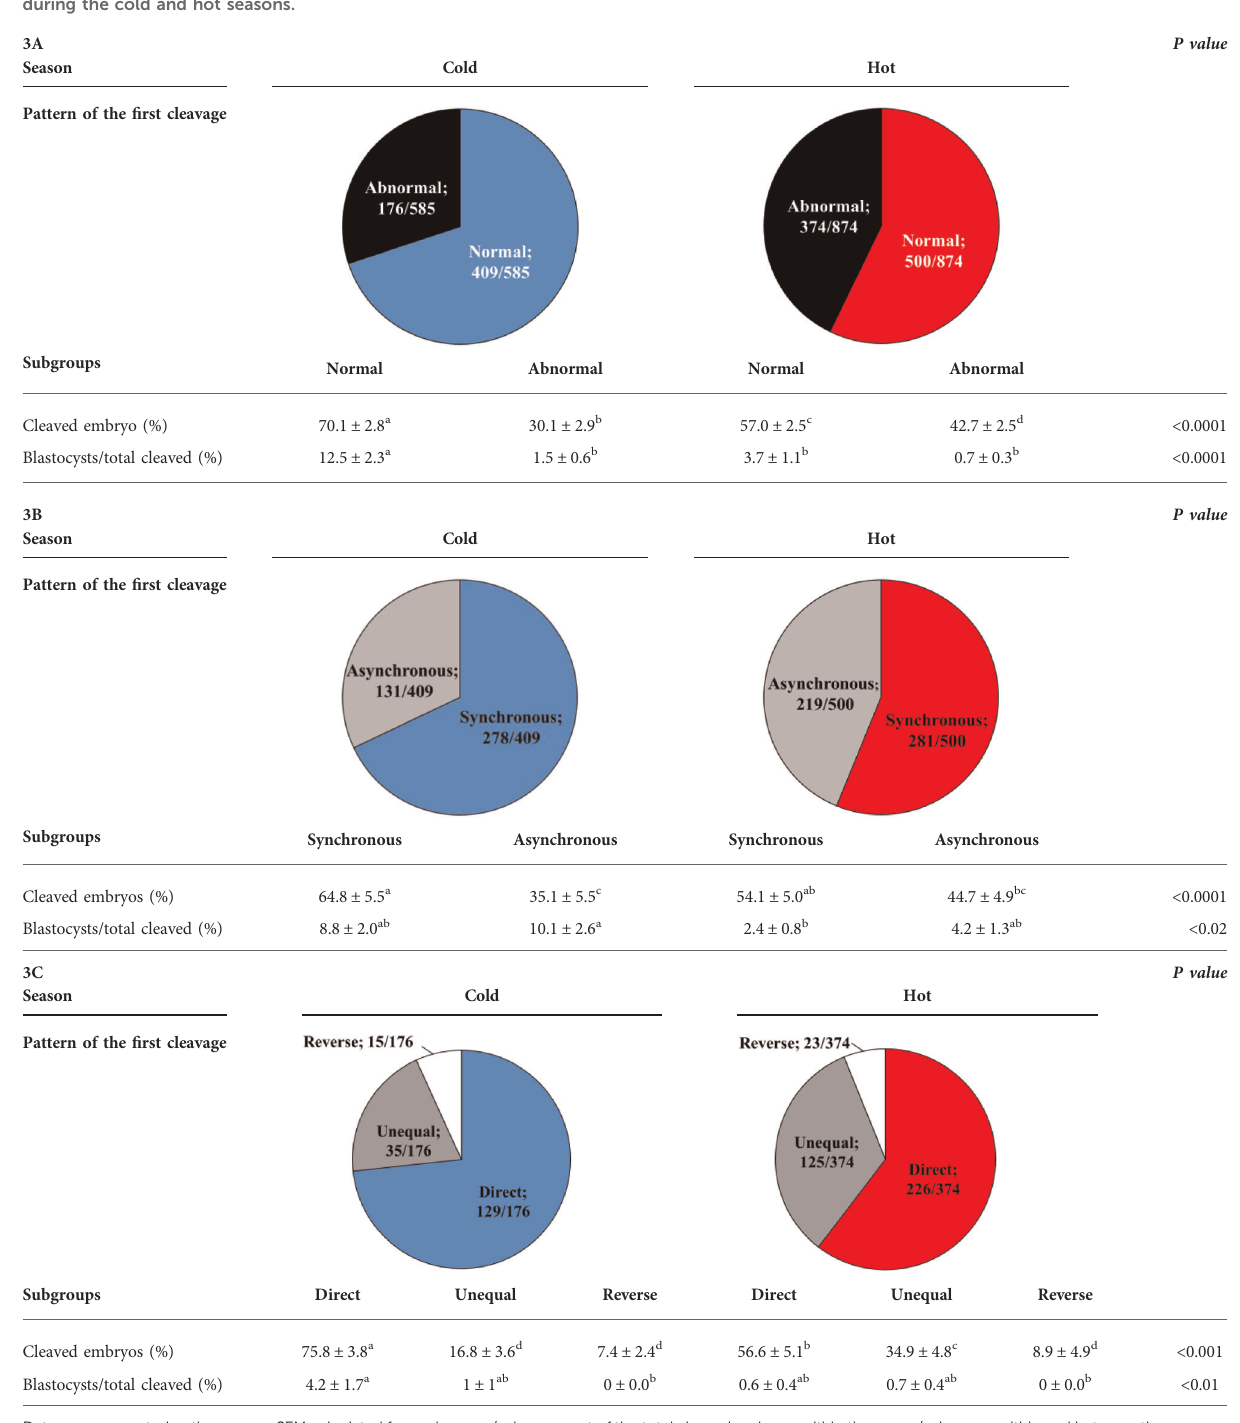
cleaved embryos ( p = 0.1; Figure 4B ). The expression of mt-ND2, HSF1, ZP3, HSP85, UHRF1, and STAT1 did not differ between the synchronously and directly cleaved embryos ( p = 0.2; Figure 4B ).